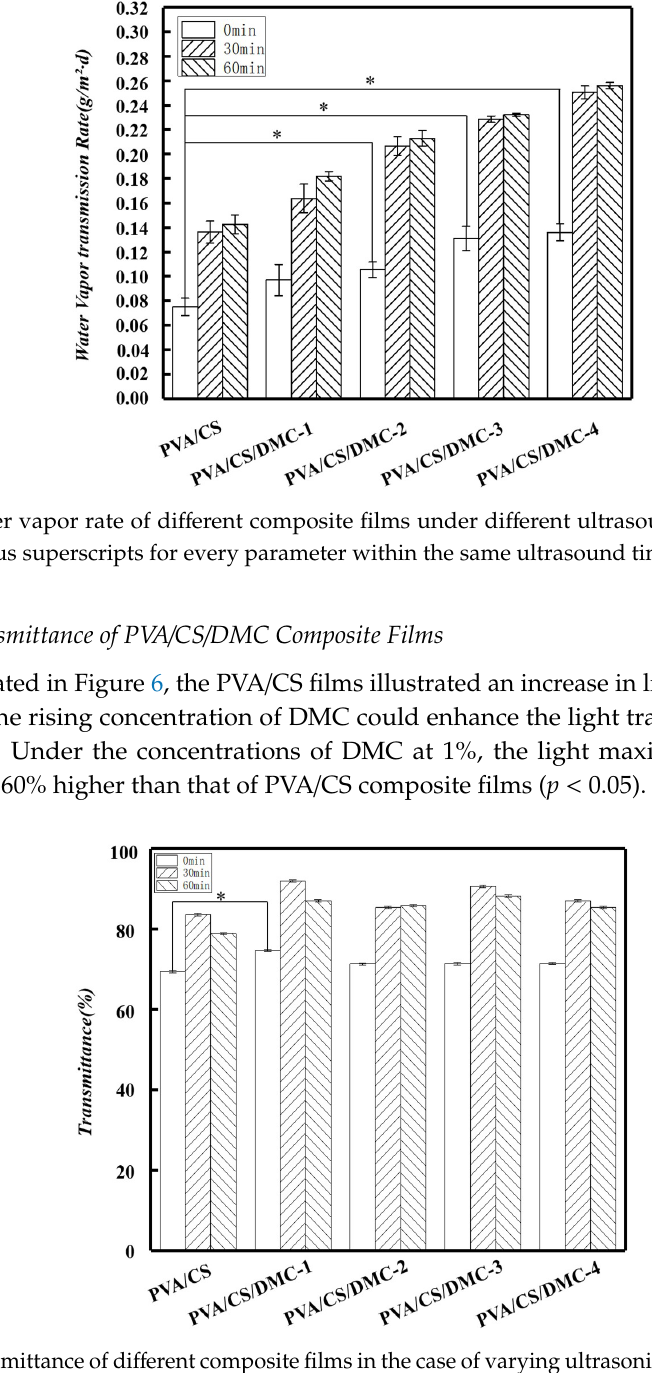
Figure 6. Transmittance of different composite films in the case of varying ultrasonication time. a Values marking various superscripts for every parameter within the same ultrasound times differ noticeably ( p < 0.05).